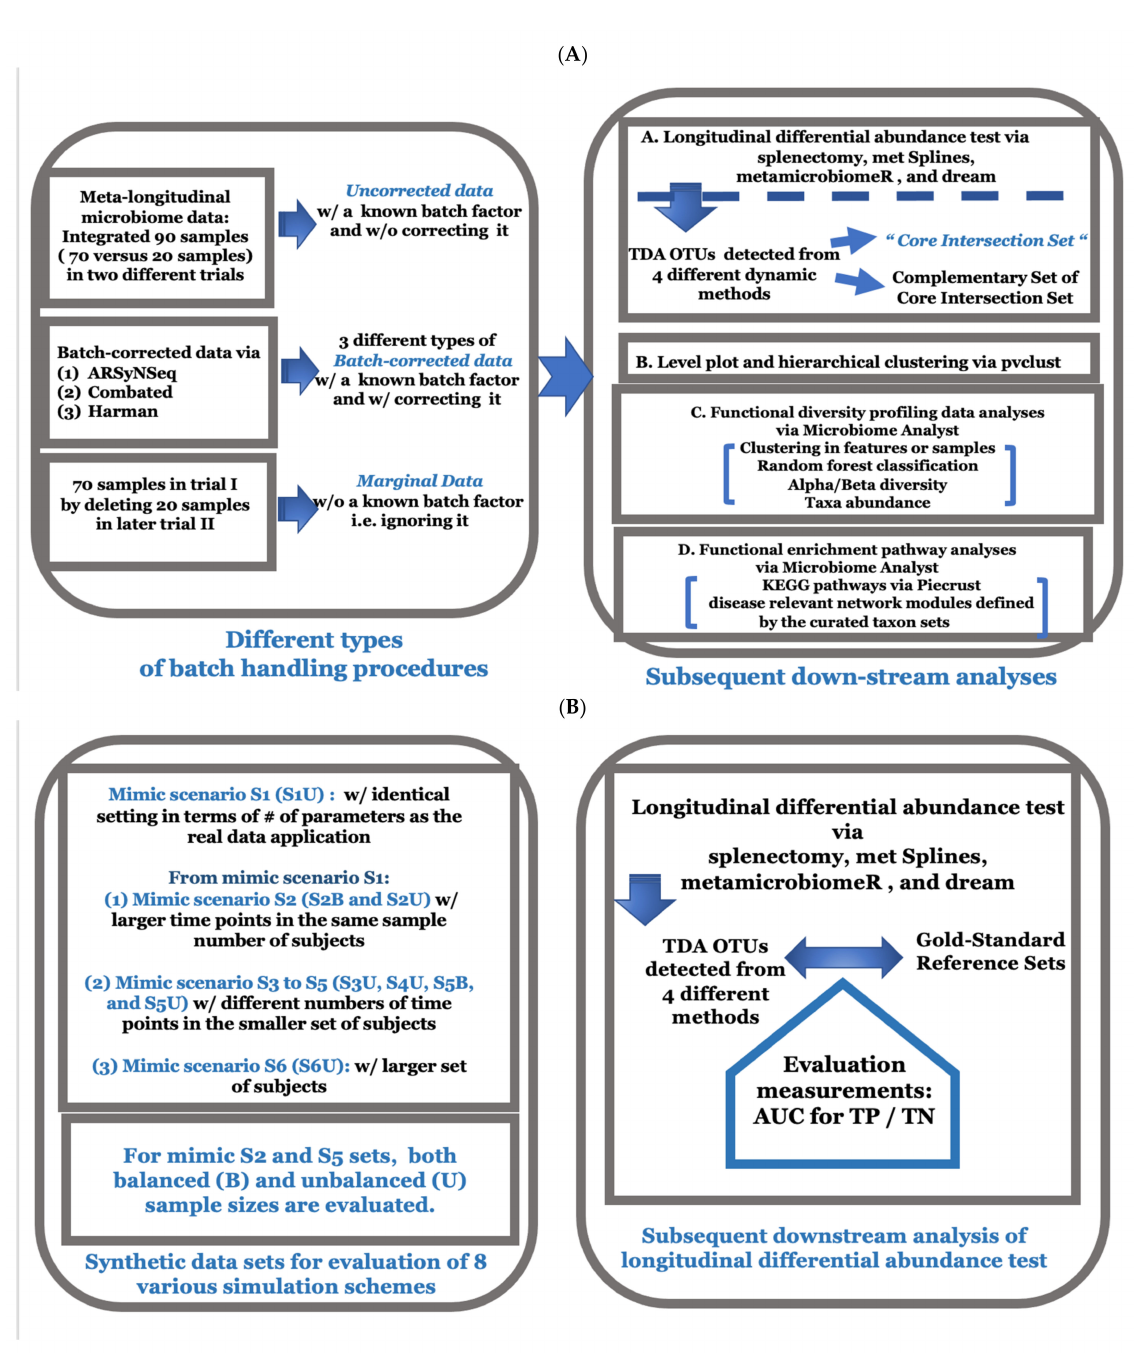
Figure 1. ( A ) Depicting a schematic illustration of this entire study in real data application. ( B ) This figure describes various simulation schemes in this